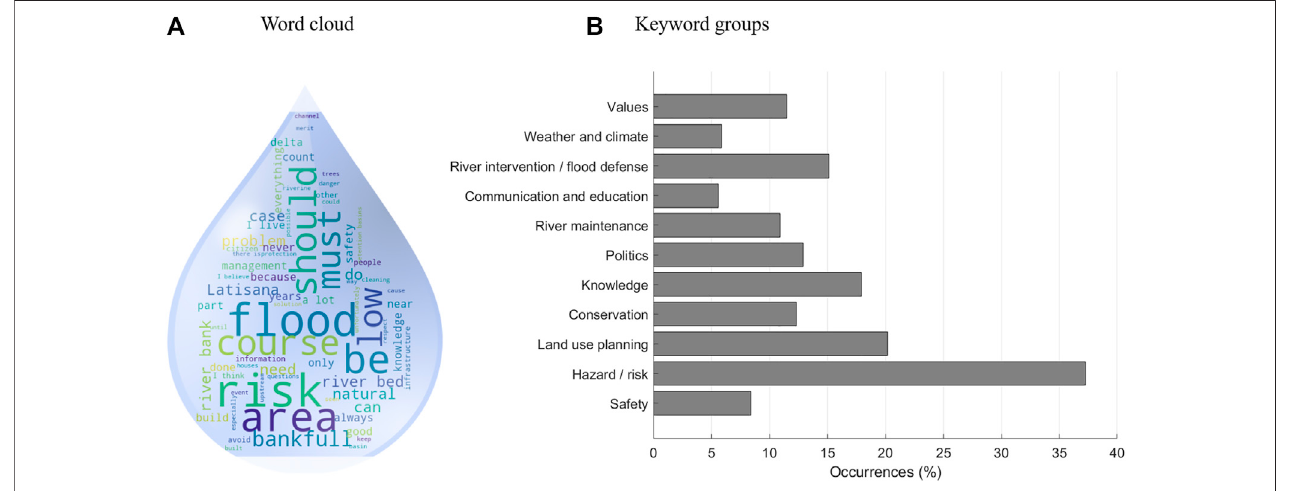
FIGURE 3 | (A) Word cloud of the free-text answer to Q5. The word cloud is based on the free-text comments, accounting for the 14% of total respondents. (B) Number of occurrences of selected keyword groups in the free-text of Q5, expressed as percentage of the total number of free-text comments.